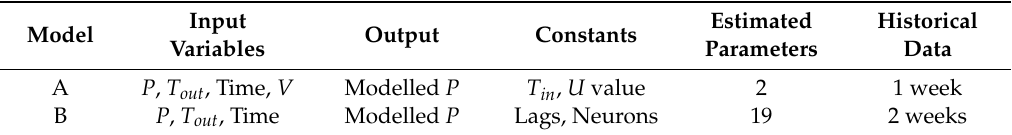
Table 6. Input variables, outputs, constants, and the number of estimated parameters for model A and